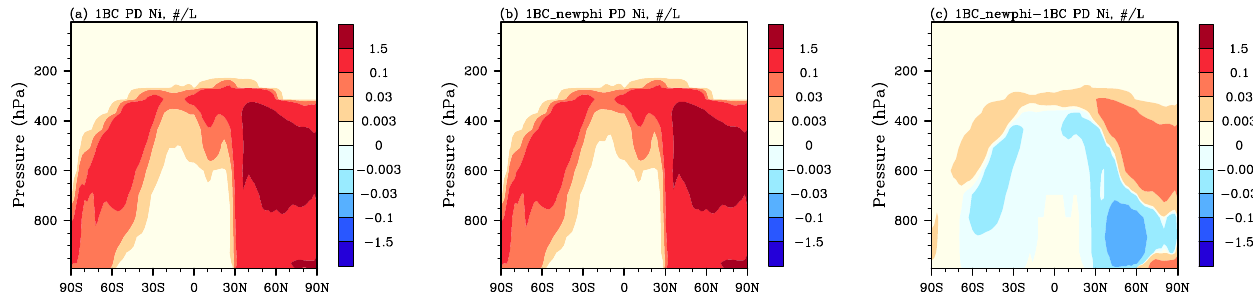
Fig. A1. Comparison of the simulated ice number concentration with (a) the original Phillips et al. (2008) scheme, (b) the new Phillips et al. (2013) schem, and (c) their